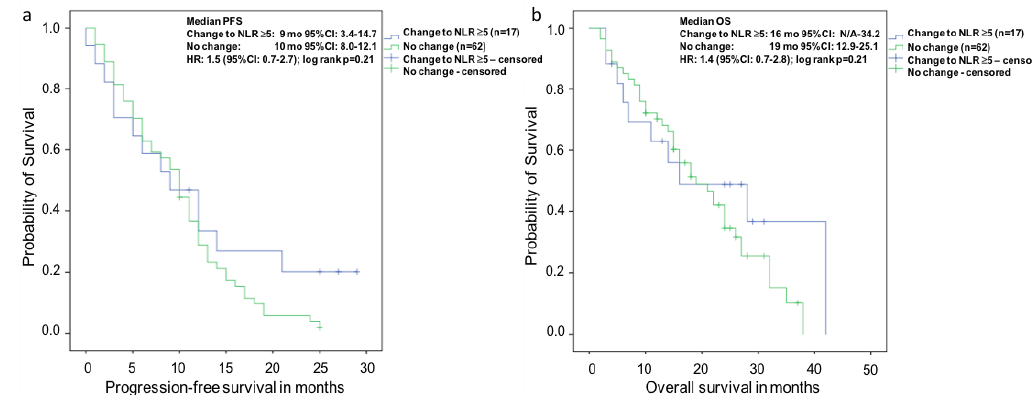
Figure 2. Kaplan-Meier analysis of the subgroup of patients with a NLR <5 at baseline for ( a ) overall survival (OS) and ( b ) progression-free survival (PFS). There was no difference of median survival in the subgroup of patients with a NLR <5 at baseline and change of NLR to >5 vs. no change after eight weeks of Abiraterone therapy (log rank p = 0.21). There equally was no difference of median PFS for change of NLR to >5 vs. no change after eight weeks of Abiraterone therapy (log rank p = 0.21).